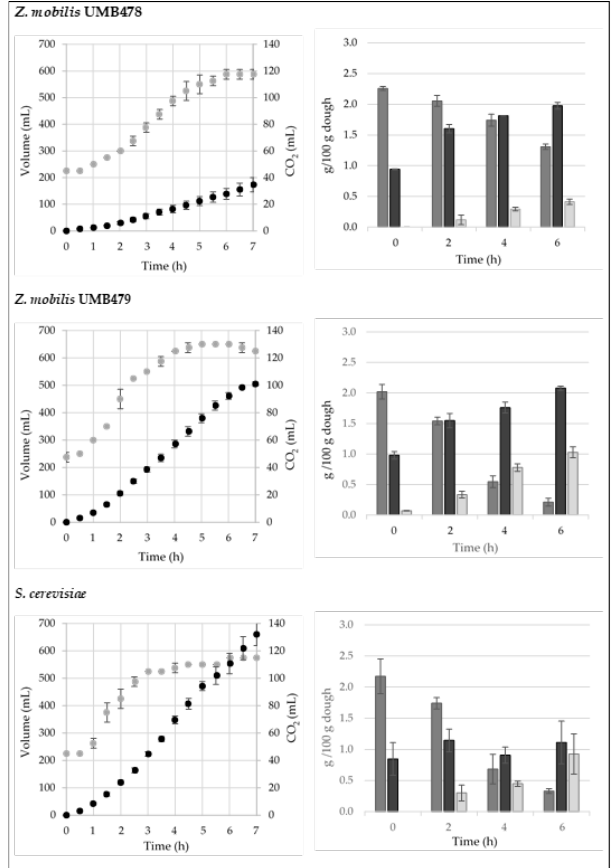
Figure 3. CO 2 production (mL, black) and dough volume increase (mL, grey) of dough samples inoculated with Z. mobilis UMB478, UMB479 and compressed baker’s yeast ( S. cerevisiae ) ( left ); time course of glucose (dark grey), maltose (black) and ethanol (light grey) (g/100 g of dough) in dough samples ( right ). Table 4. Dough leavening properties (mean and standard deviation values of two technological replicates): lag leavening time (LLT, h), leavening rate (LR, mL/h) and maximum dough volume (DV max, mL) of dough samples leavened with the two Z. mobilis wild strains and baker’s yeast for comparison purposes.